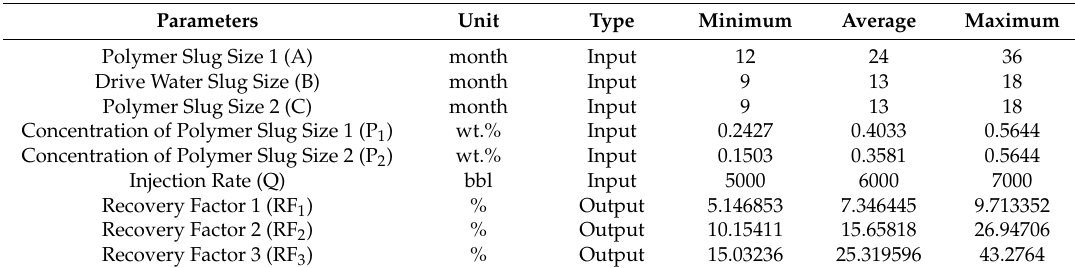
Table 4. Range of variables in the